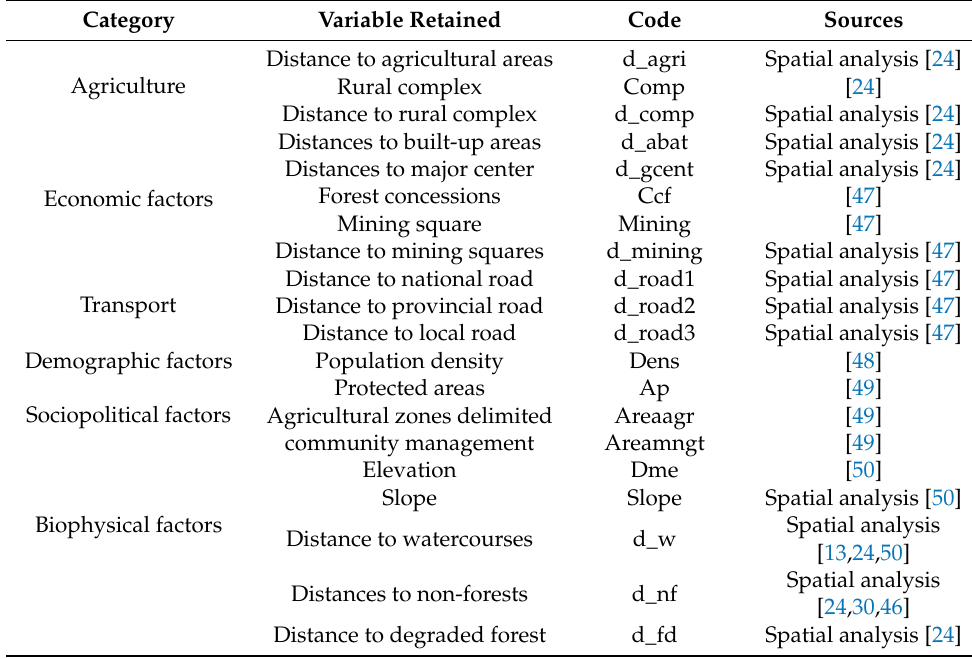
Table 2. Explanatory variables of